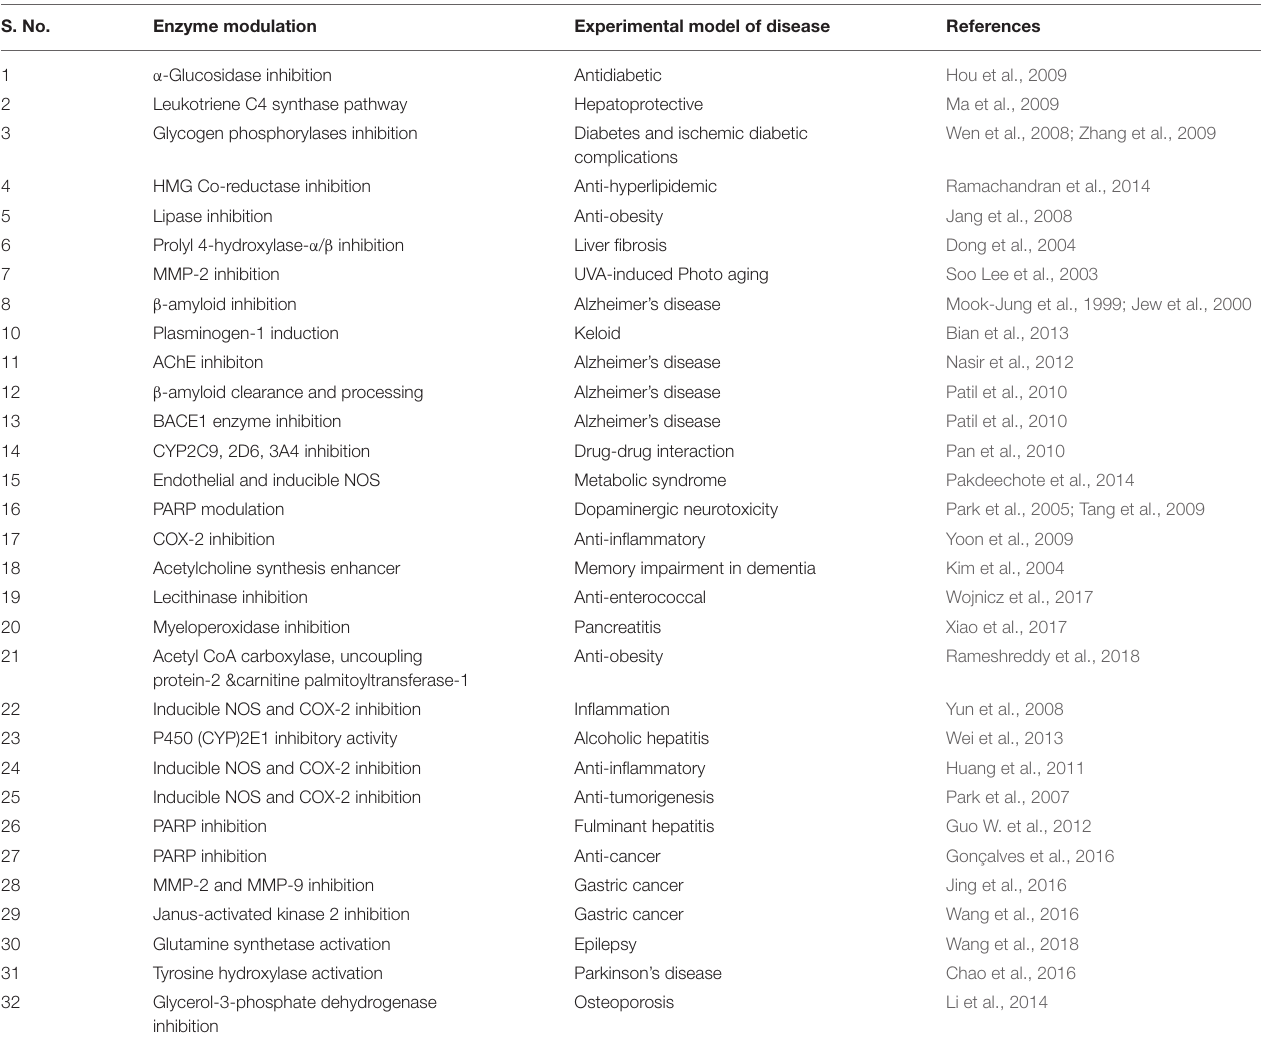
TABLE 4 | The enzyme modulating properties of asiatic acid. S.